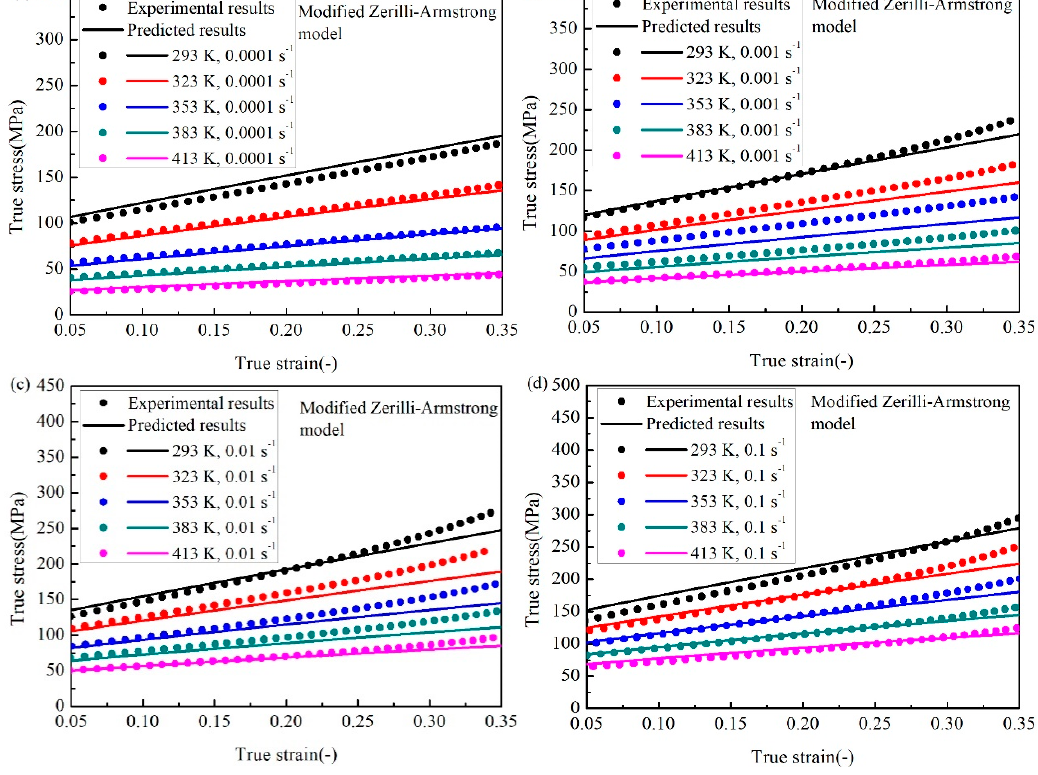
Figure 11. Comparison between the experimental data and predicted values by the modified Z–A model at the strain rate of ( a ) 0.0001 s − 1 , ( b ) 0.001 s − 1 , ( c ) 0.01 s − 1 , and ( d ) 0.1 s − 1